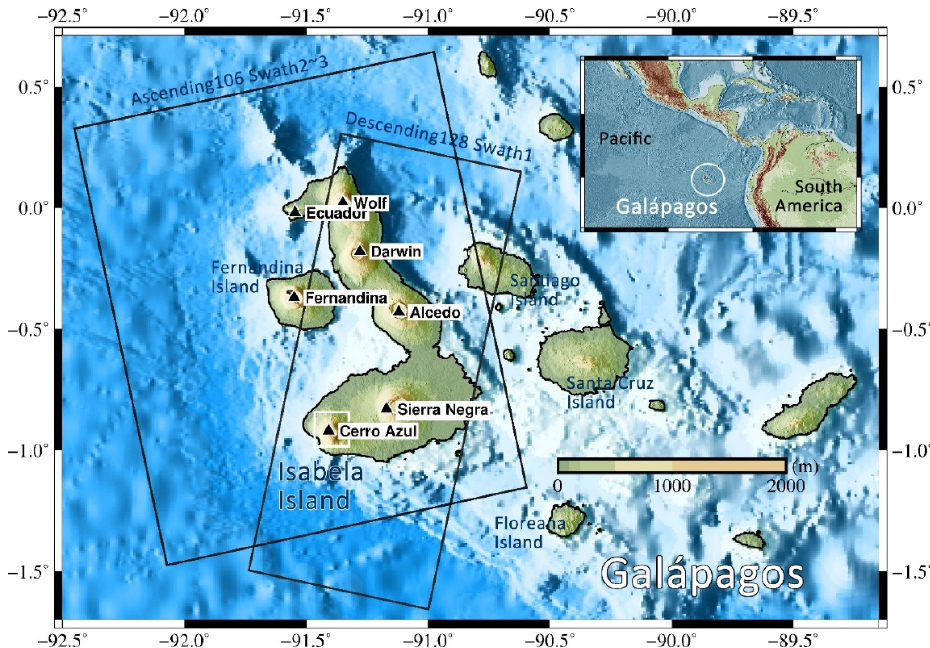
Figure 1. Topography of Isabela Island, Galápagos Archipelago. The black rectangles represent interferometric synthetic aperture radar (InSAR) data coverage. The elevation model is from the Shuttle Radar Topography Mission (SRTM) [48]. The inset map shows the location of the Galápagos in the Pacific, off the west coast of South America in the white circle.